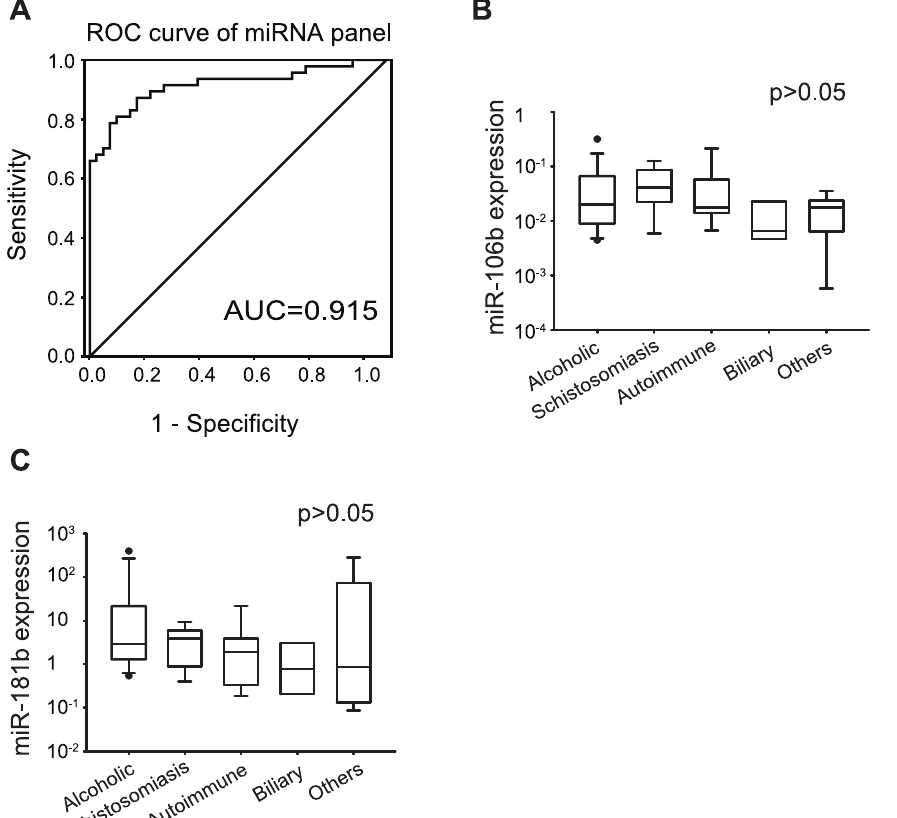
Figure 5. Plasma miR-106b and miR-181b levels in non 2 CHB-related cirrhosis cohort. ROC curve analysis showed that the diagnostic power of the miRNA classifier was significant high in non-CHB cirrhosis cohort (A). There was no statistic difference between the two miRNAs levels in patients with different types of cirrhosis (B and C), indicating that the dysregulated levels of plasma miRNAs were not etiology-specific.